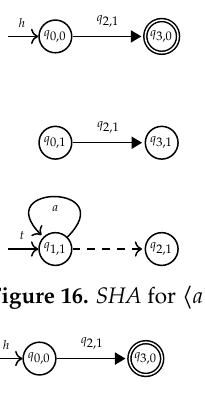
Figure 16. SHA for